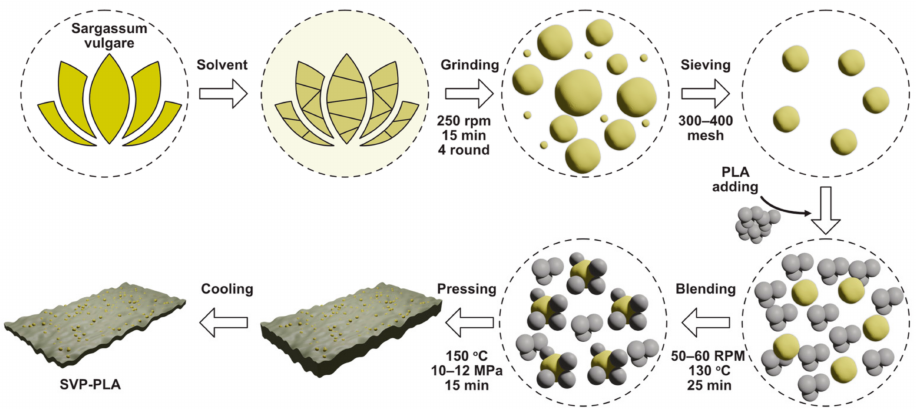
Figure 1. Schematic illustration of the S. vulgare powder-poly-lactic acid (SVP-PLA) composite